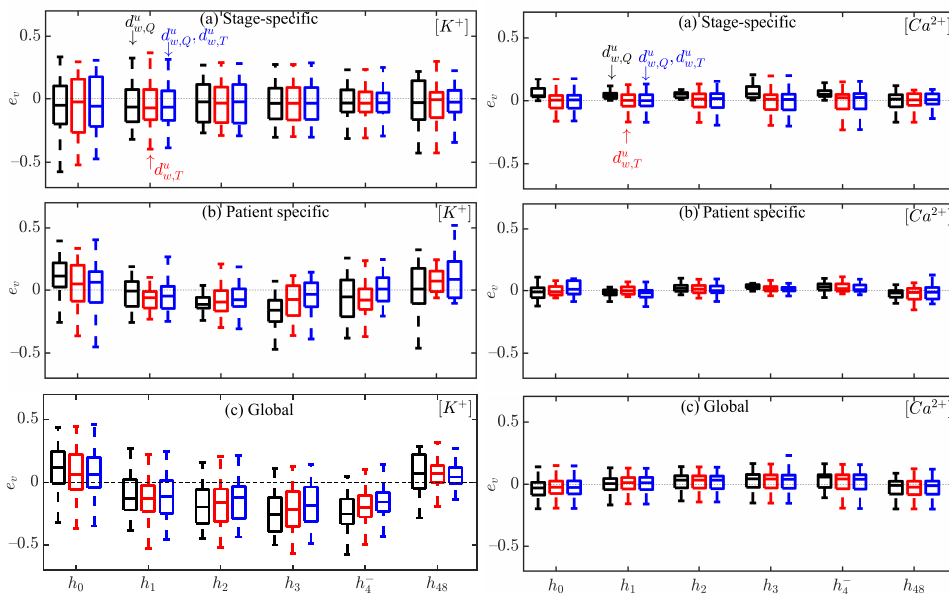
Figure 7. Box plots of [ K + ] and [ Ca 2 + ] estimation errors e v during HD stages for all patients using d u (black), d u (red) and the combination of d u w,T w,Q specific ( middle ) and global ( bottom ) approaches. The central line indicates the median, whereas top and bottom edges show the 25th and 75th